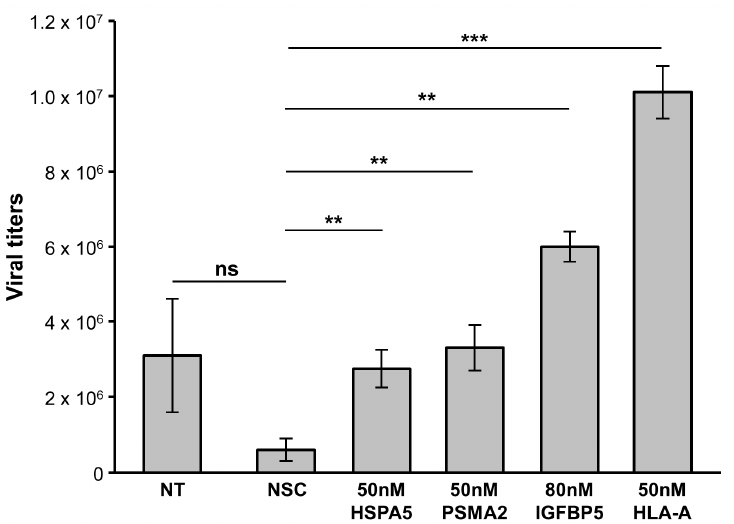
Figure 8. Effect of indicated siRNA treatment on ZIKV titers in U251 cells at 48 hpi after indicated genes and proteins knocked down. Error bars represent standard deviation. 2-tailed Students t -test was used to determine statistical significance and p -values. * p -value < 0.05; ** p -value < 0.01; *** p - value < 0.001; ns: not significant; NT; not treated with siRNA; NSC: scrambled non-silencing control.